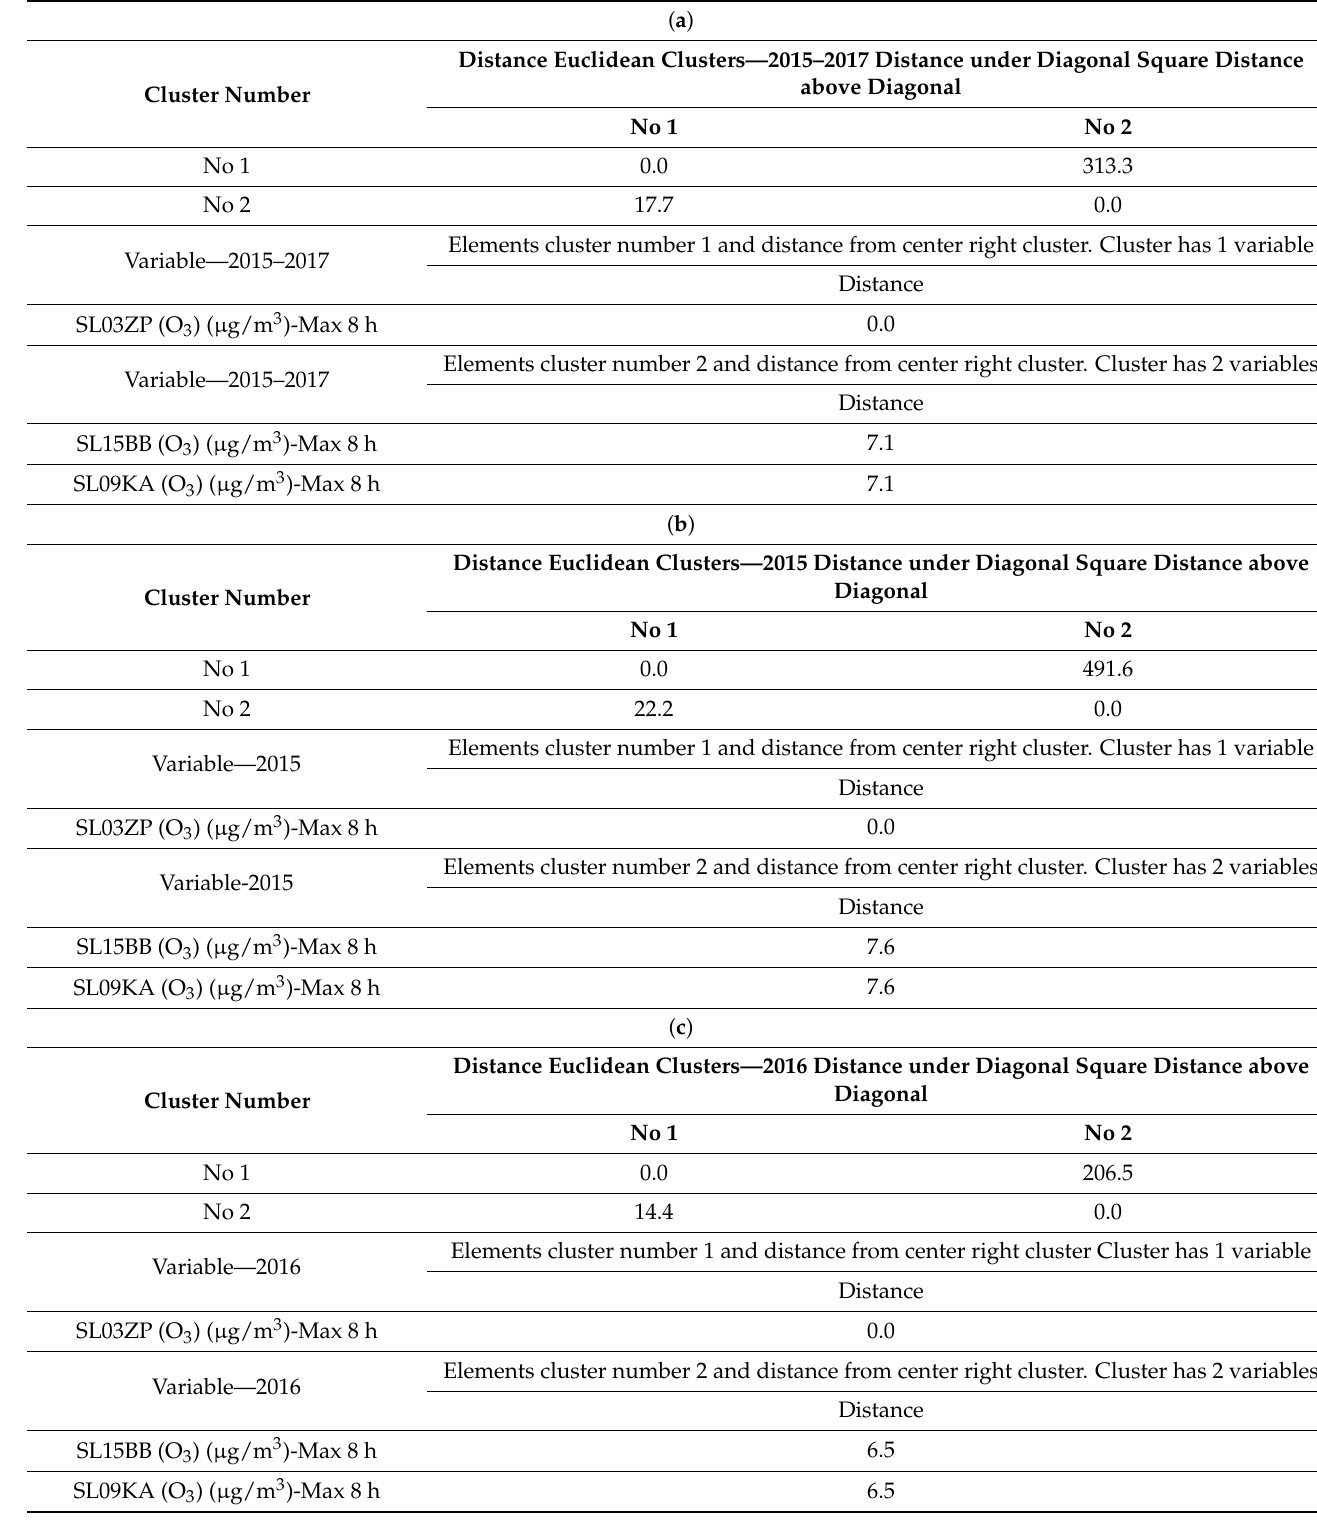
Table 5. ( a ) Cluster analysis for period 2015–2017. ( b ) Cluster analysis for year 2015. ( c ) Cluster analysis for year 2016. ( d ) Cluster analysis for year 2017.